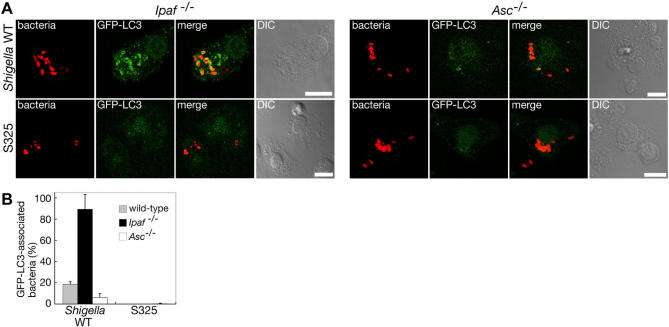
Differential Regulation of Shigella-Induced Autophagy by Ipaf and ASCGFP-LC3-expressing Ipaf-deficient or ASC-deficient BMMs were infected with Shigella WT or TTSS mutant.(A) At 30 min after infection, the infected cells were immunostainted with Cy5-labeled anti-Shigella LPS antibody (colored red) and examined using a confocal microscope. The merged image with Cy5 bacteria and GFP fluorescence, and differential interference contrast (DIC) were also shown. Scale bars = 10 μm.(B) GFP-LC3-associated intracellular bacteria were quantified. Error bars represent mean ± SD.